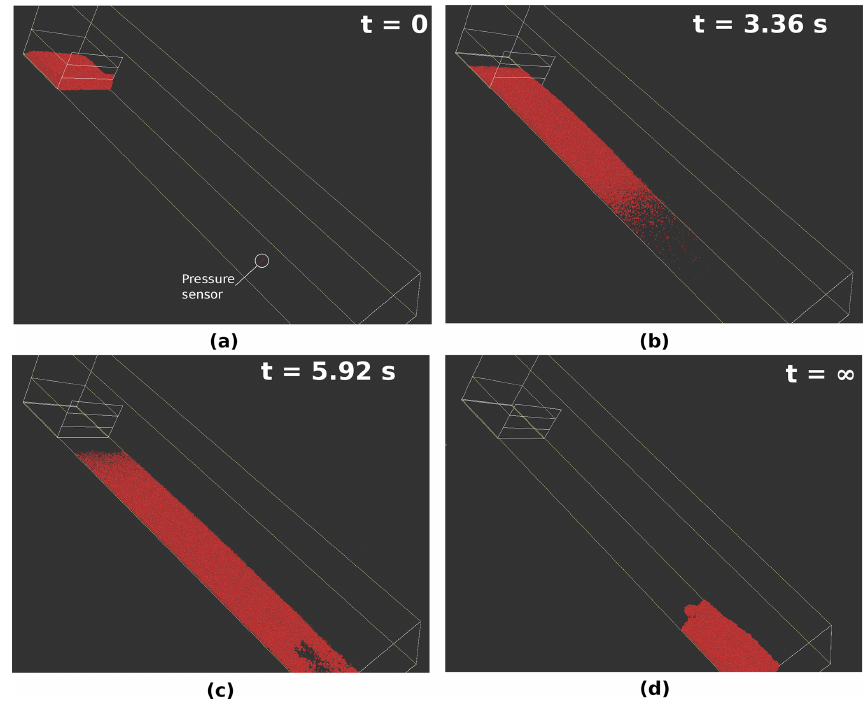
√ k 1 /k 2 = 0 . 3: directly after opening the reservoir’s gate (a) ,